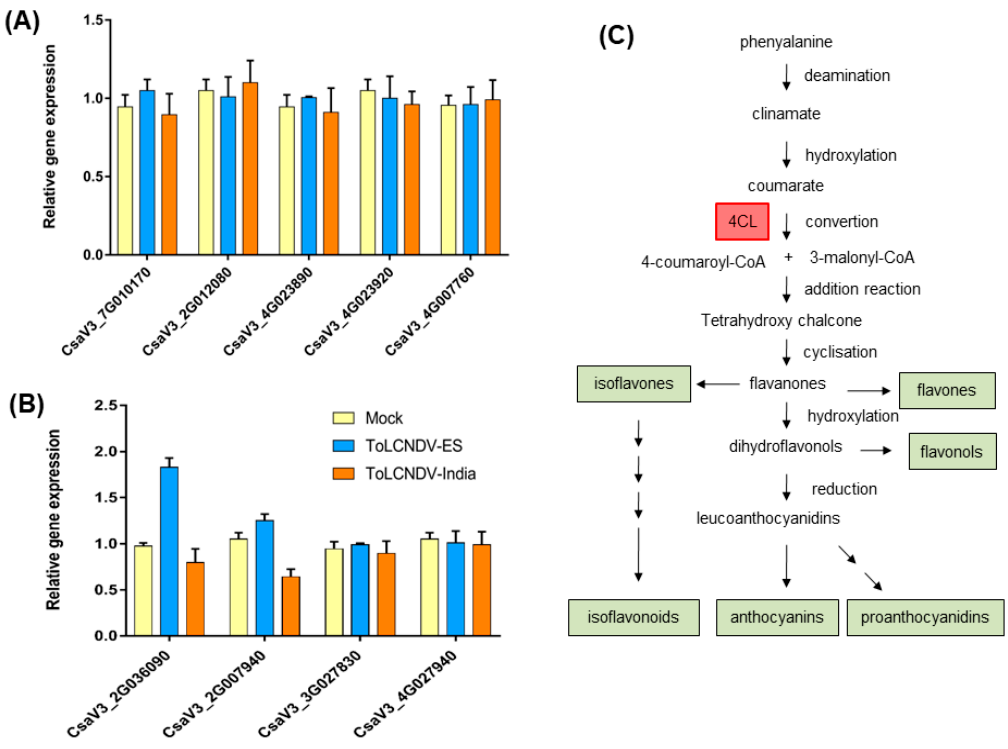
Figure 9. Relative expression of some potential genes in differently infected cucumber by qRT-PCR. Four genes belonging to the flavonoid pathway and five genes related to the oxidation/reduction process were chosen based on the RNA-seq data and their expression checked by qRT-PCR. The bar graphs show the changing expression of the candidate genes related to the ( A ) oxidation–reduction process and ( B ) flavonoid pathway at 21 dpi under the two ToLCNDV infections compared with the mock plants. ( C ) Flavonoid pathway with highlighted 4-coumarate-CoA ligase (4CL) in the red box.